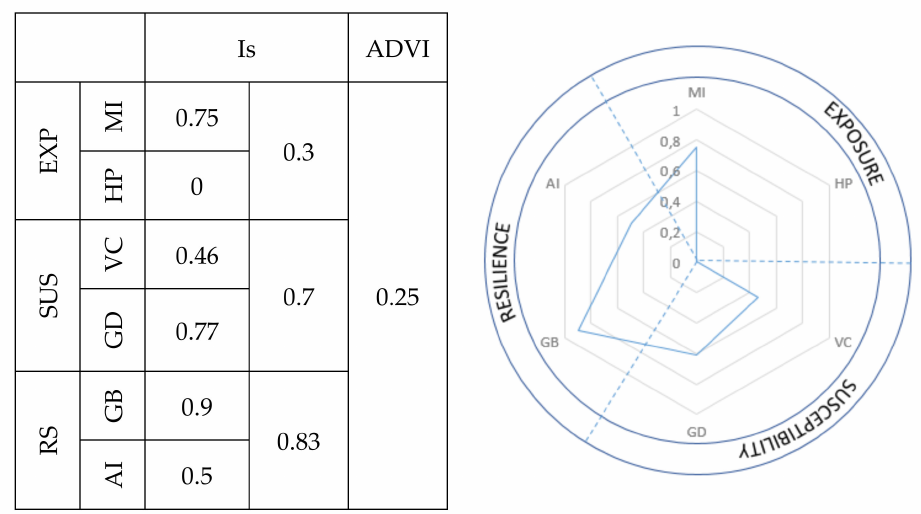
Figure 3. ( Left ) Table with partial vulnerability indices (Is) and the DVI calculated. ( Right ) Radar graphic. Legend: MI: marine influence; HP: human pressure; VC: vegetation cover; GD: geomorphol- ogy of the dune system; GB: geomorphology of the beach; AI: aeolian influence; EXP: exposure; SUS: susceptibility; RS: